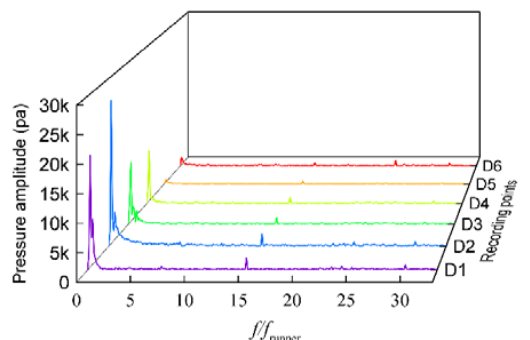
Figure 9. Spectral analysis of the pressure signals of the six recording points in the draft tube (16 deg GVO).